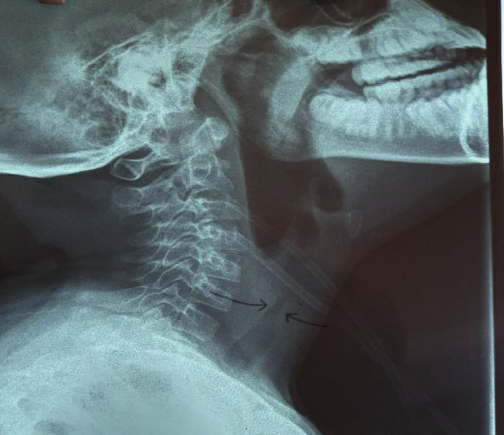
Figure 3: Lateral cervical X-ray showed partial narrowing in the region of the cricoid cartilage (arrowed).